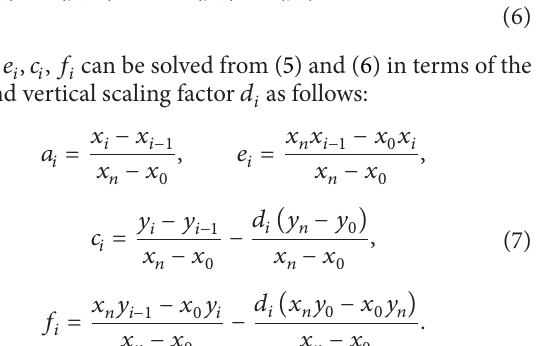
Figure 2: Fractal interpolation